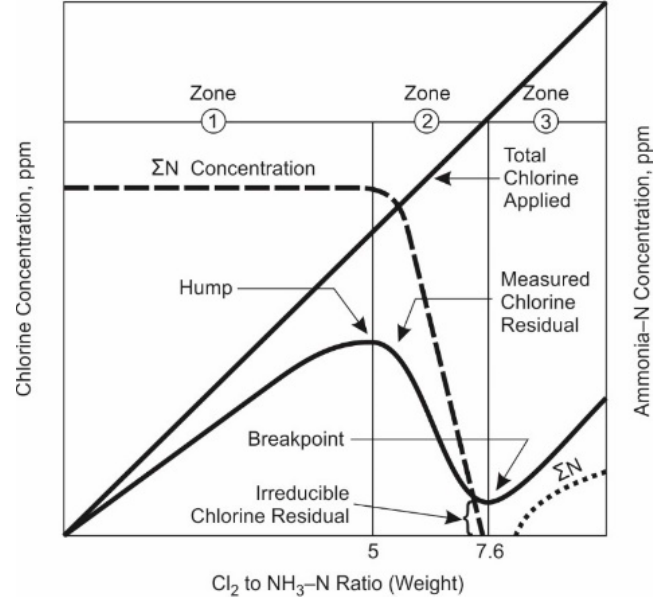
Figure 9. Breakpoint chlorination.